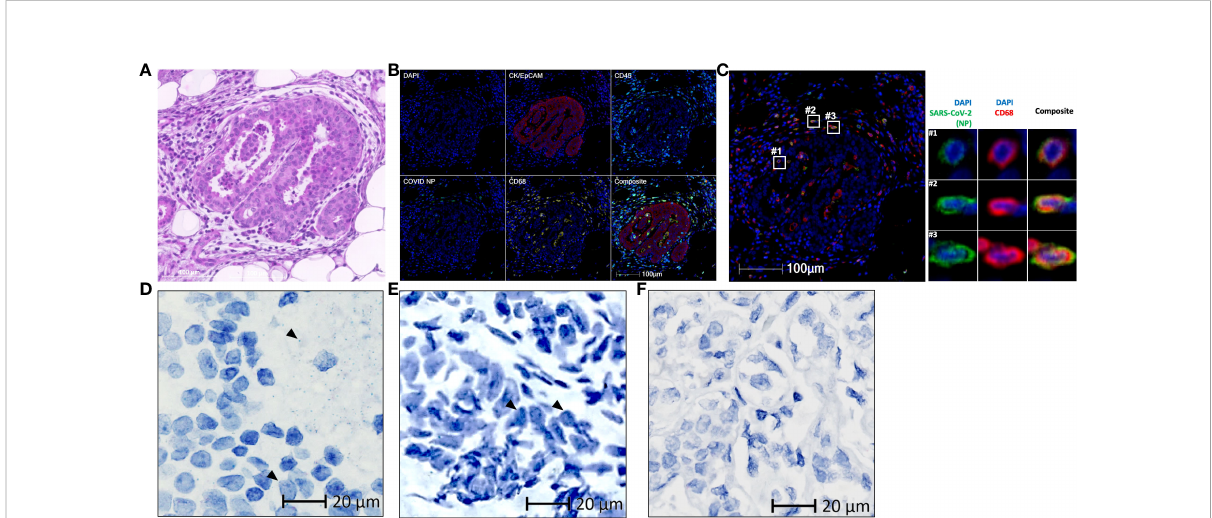
FIGURE 2 Residual SARS-CoV-2 detected in the breast tissue of patient 2 using multiplex immunohistochemistry and RNAscope (A) Representative images of the breast tissue stained with hematoxylin and eosin, with differentiated staining of nuclear (hematoxylin) and cytoplasmic (eosin) components. (B) Representative images of the breast tissue stained for DAPI (blue), CK/EpCAM (red), CD45 (cyan), SARS-CoV-2 nucleocapsid protein (COVID NP; green), and CD68 (yellow). (C) Representative images of the breast tissue stained for DAPI (blue), SARS-CoV-2 nucleocapsid protein (COVID NP; green), and CD68 (red). (D – F) Representative images of (D, E) the breast tissue obtained from patient 2 and (F) normal breast tissue obtained from patients not affected by COVID-19, subjected to RNAscope in situ hybridization with a nuclear component (hematoxylin) counterstained. SARS-CoV-2 spike RNAs are labelled as green dots, examples of the green dots are marked by black arrows. (A – C) Scale bar, 100 m m. (D – F) Scale bar, 20 m